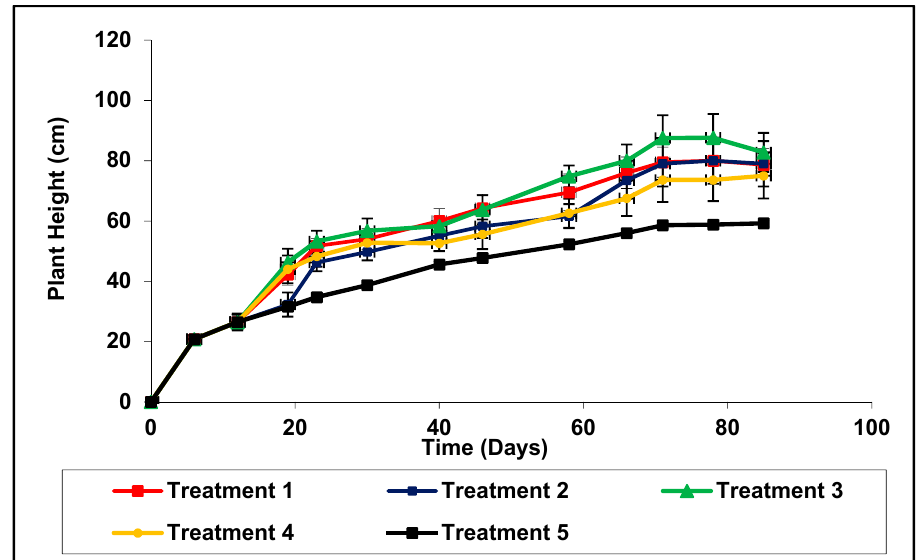
Figure 1. Variation of plant height with time in the pot experiment. Each data point is a mean of four replicates. Treatment 1 − inorganic fertilizer only (Urea, TSP and MOP), Treatment 2 − rice husk biochar coated Urea, TSP and MOP, Treatment 3 − inorganic fertilizer (Urea, TSP and MOP) with anaerobically digested rice straw compost only, Treatment 4 − rice husk biochar Urea, TSP and MOP with anaerobically digested rice straw compost and Treatment 5 − no fertilizer as control. Table 2. Effect of different treatments on the growth and yield parameters of rice cultivated in pots.